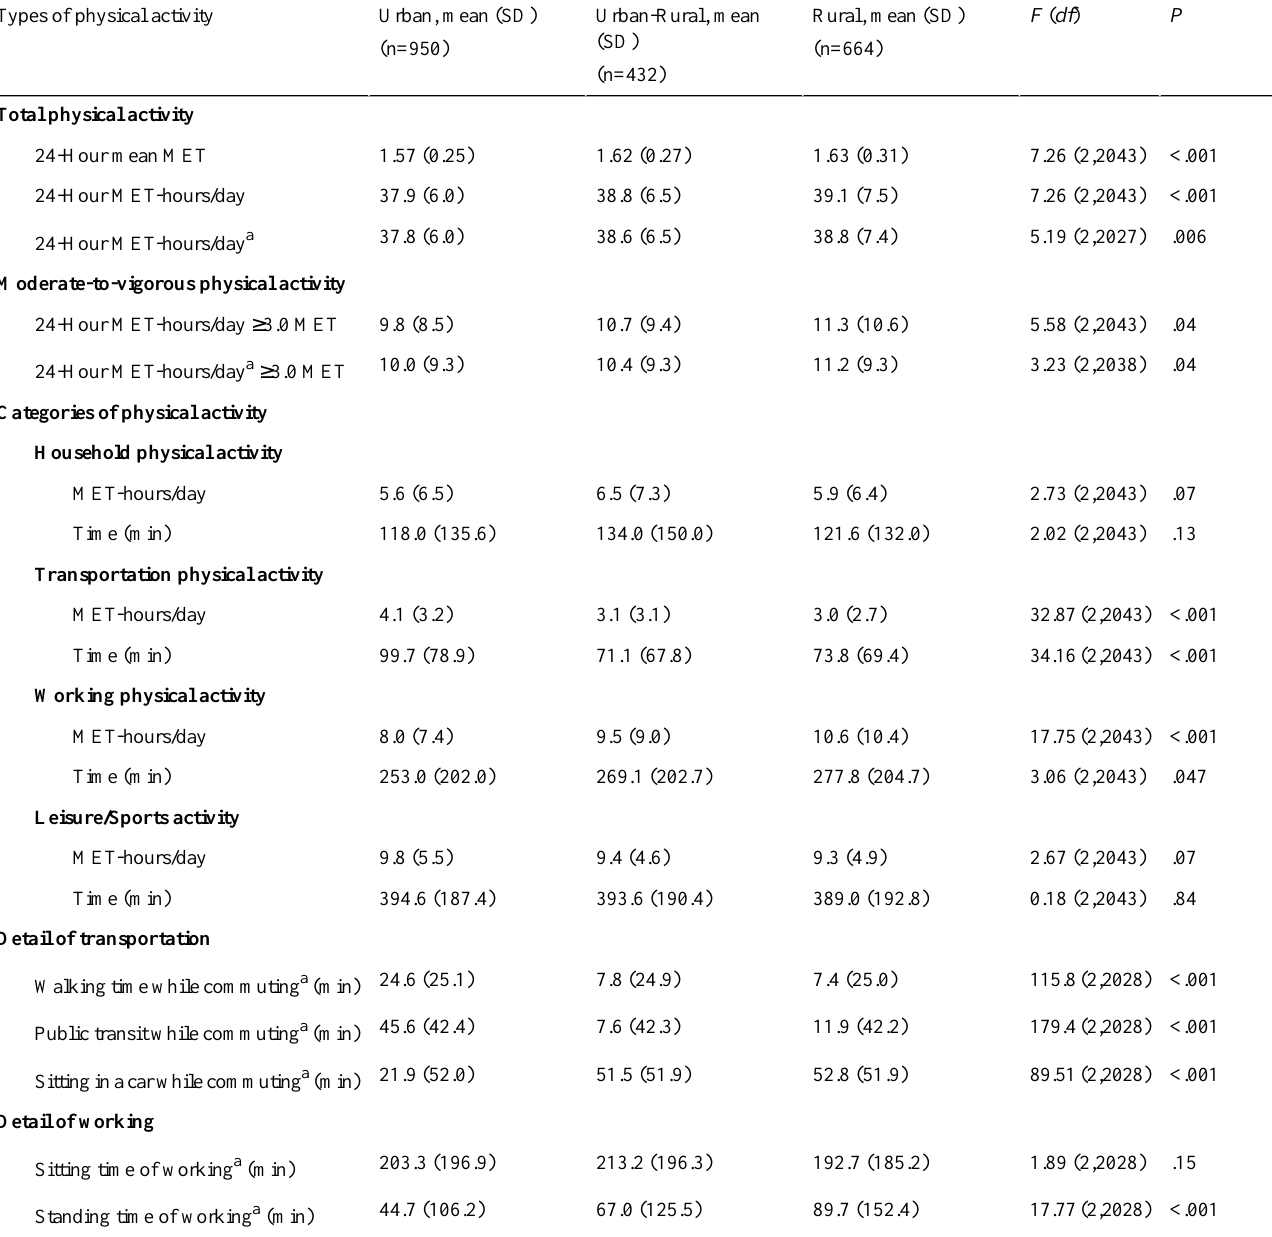
Table 2. Comparison of physical activity in each region